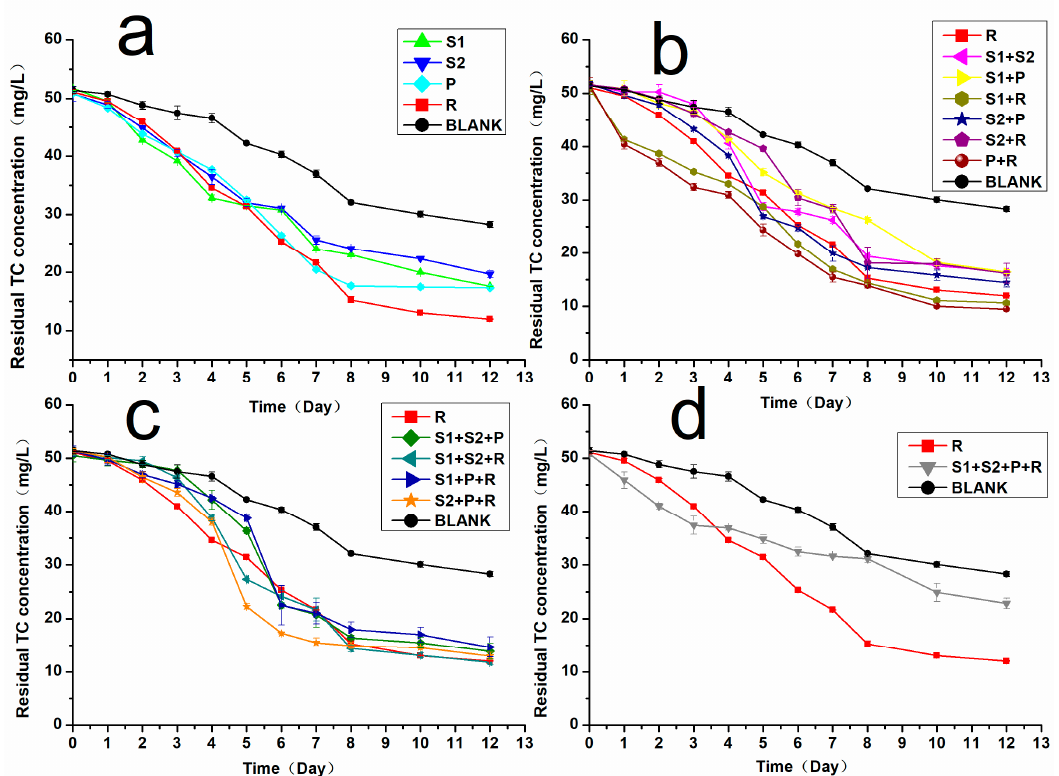
Figure 1. Residual tetracycline (TC) concentration in the lysogeny broth (LB) medium: ( a ) TC degradation of each single strain, ( b – d ) Comparision between the best strain ( Raoultella sp. XY-1) and the bacterial consortia. S1: A. faecalis S-1; S2: A. faecalis S-2; P: Pandoraea sp. XY-2; R: Raoultella sp. XY-1. BLANK stands for control groups without adding bacteria.